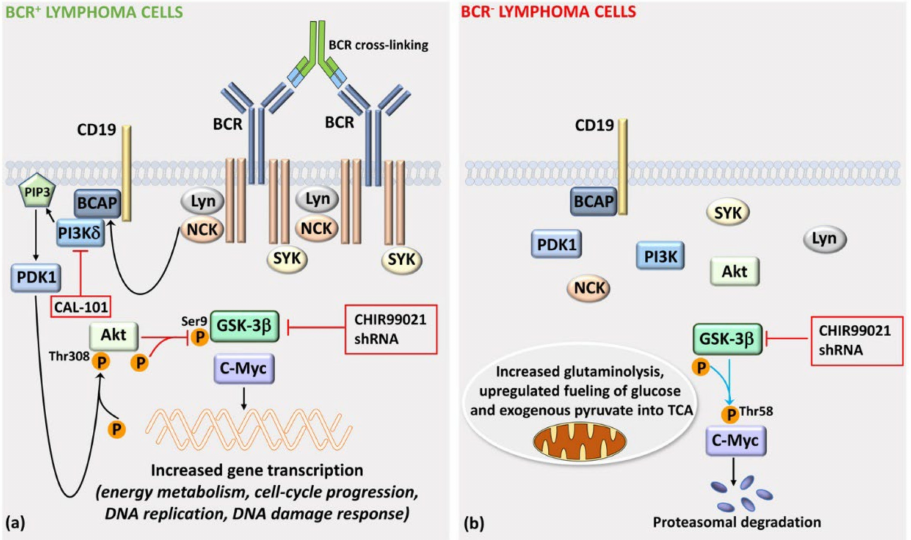
Figure 5. BCR-mediated inactivation of GSK-3 β upregulates c-Myc-dependent gene transcription in mouse and human B-cell lymphoma. ( a ) Upon BCR cross-linking (which mimics aberrant BCR upreg- ulation), a PI3K δ /PDK1/Akt axis leads to inhibitory phosphorylation of GSK-3 β . As a consequence, c-Myc is not degraded via the proteasome and increases the transcription of a set of genes involved in metabolism, cell cycle progression, and DNA replication and repair. The PI3K δ CAL-101 could oppose c-Myc-dependent transcription. The GSK-3 β inhibitor CHIR99021 or shRNA decreased transcription of C-Myc-regulated genes. ( b ) In cells where the BCR has been genetically depleted, GSK-3 β is active; hence, it phosphorylates c-Myc on the Thr58 residue, thereby leading to its proteasomal degradation. The GSK-3 β inhibitor CHIR99021 or shRNA downregulates c-Myc degradation. The BCR- cells try to compensate their metabolic vulnerability via increased glutaminolysis and upregulated fueling of glucose and exogenous pyruvate into TCA. Abbreviations used: SYK, spleen tyrosine kinase; Lyn, Lck/Yes novel tyrosine kinase; NCK, noncatalytic region of tyrosine kinase; BCAP, B-cell adaptor for PI3K; PIP3, phosphatidylinositol (3,4,5)